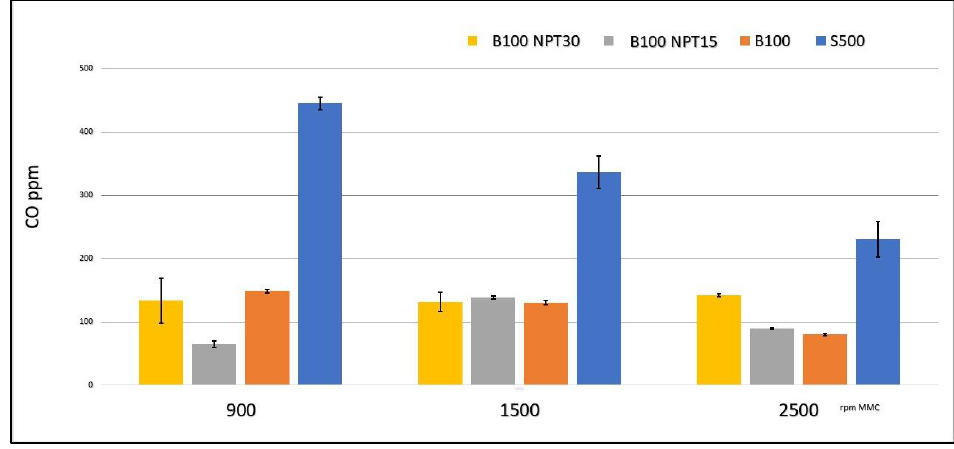
Figure 4. CO emissions (ppm) during fuel burning (S-500, B100-NTP15, and B100-NTP30) at different engine speeds (rpm).